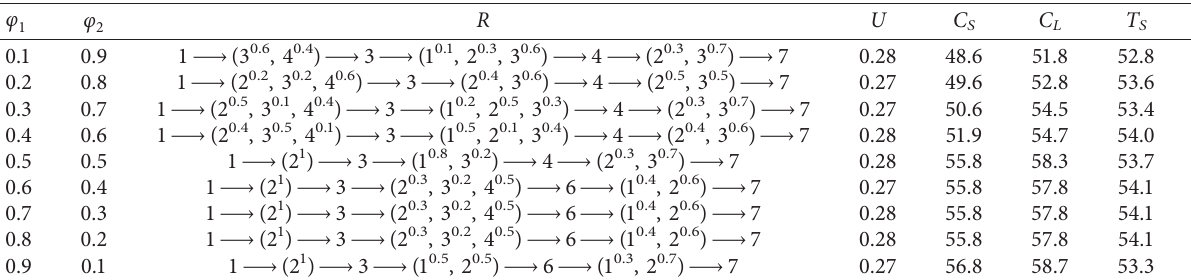
and φ on the transportation plans. 1 2